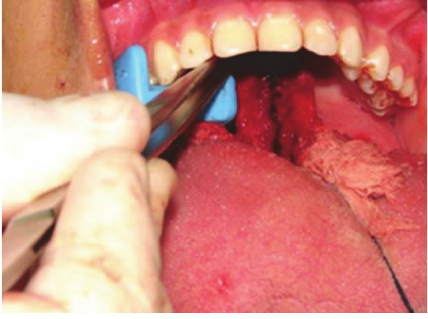
Figure 4: Excision of the